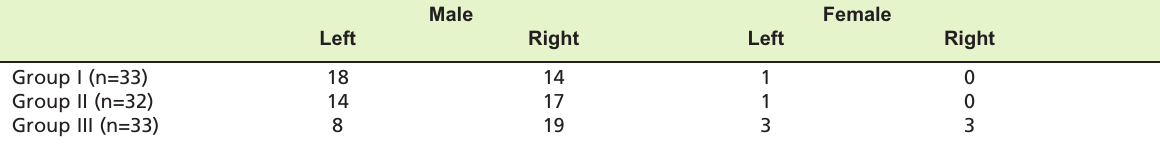
Sex distribution and side of involvement Table II: